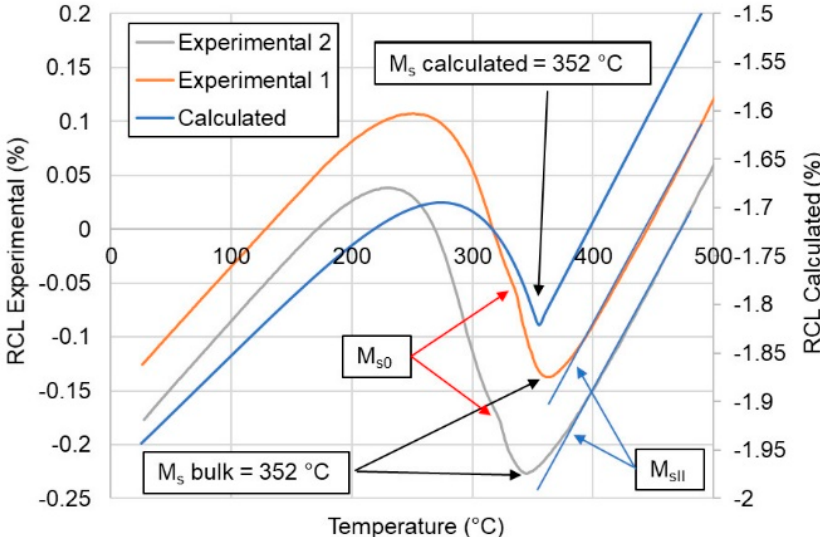
Figure 2. Analysis of the martensitic transformation according to the JMatPro simulation and the dilatometric study. RCL: relative change in length.